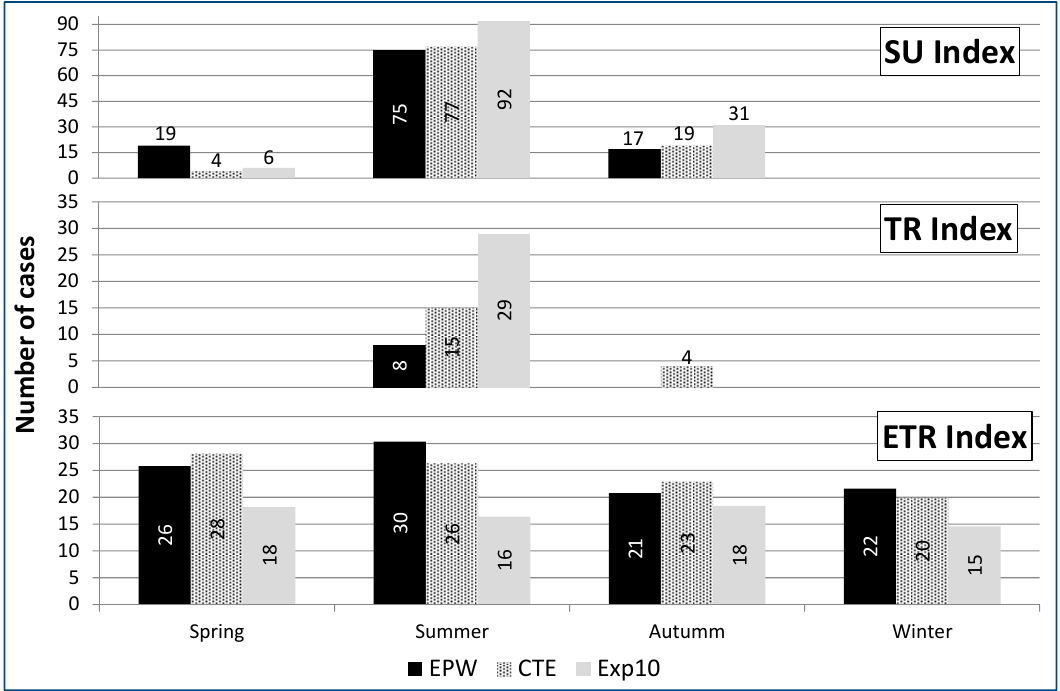
Figure 3. Seasonal evolution of three climate indices: the number of days with daily maximum temperature above 25 °C (SU), the number of days with daily minimum temperature above 20 °C (TR) and the extreme temperature range (ETR), for the three climate databases of Madrid: CTE, EPW and Exp10.